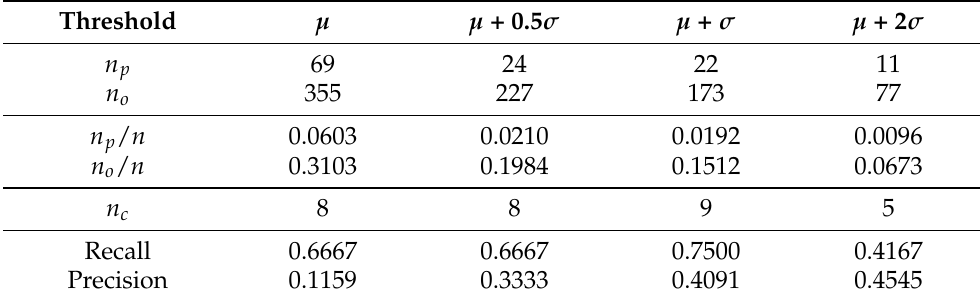
Table 3. Various parameters and ratios of the experiment measured using the raw Smile scale value (test data: number of whole data n = 1144, number of event points n e =